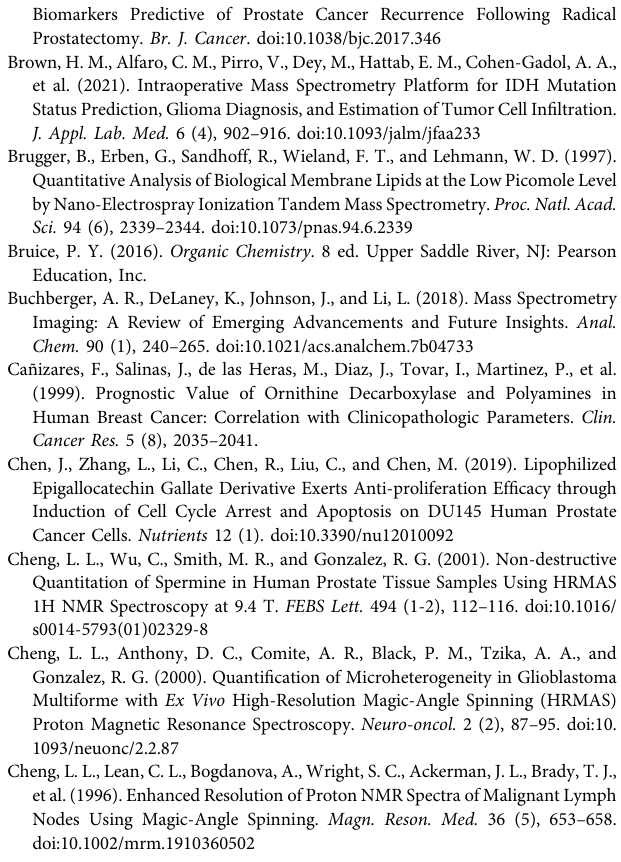
Table S1 | Comparison of HRMAS NMR and MALDI MSI